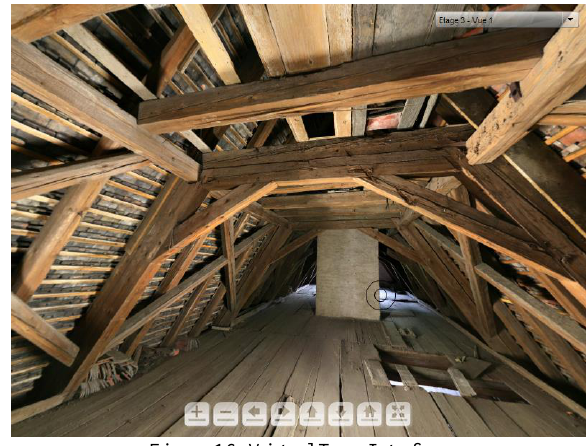
Figure 16: Virtual Tour Interface